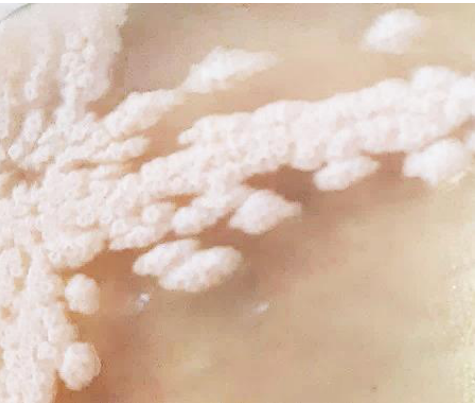
Figure 1. Colonies of B. licheniformis 24 on Luria–Bertani (LB) agar medium. The initial study of the strain’s ability to produce extracellular polysaccharides was performed in flasks, in a fermentation medium containing 50 and 100 g/L glucose or fructose as a carbon source. EPS production kinetics are shown in Figure 2. B. licheniformis 24 was able to synthesize more exopolysaccharides from glucose than from fructose at both sugar concentrations, reaching a maximum at 33 h of cultivation. The higher concentration of the carbon sources significantly increased the difference in the conversion between them, leading to higher amounts of both EPS: 3.11 and 2.17 g/L from glucose and fructose, respectively (Figure 2b).